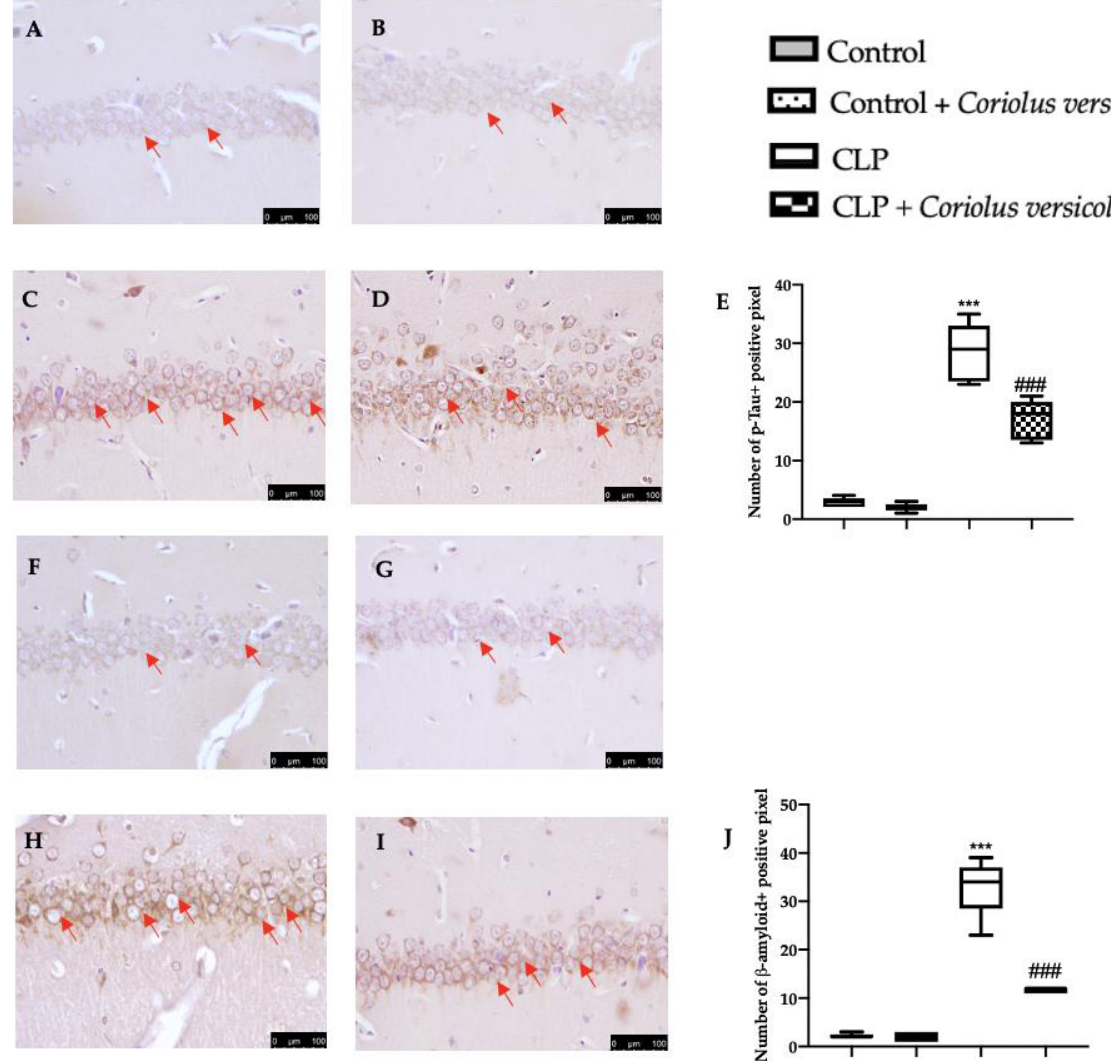
Figure 14. Coriolus versicolor reduced phosphorylated-Tau (p-Tau) and A β expression in hippocampus induced by CLP 28 days after surgery. Immunohistochemical analysis of p-Tau: Control ( A ), Control + Coriolus versicolor ( B ), CLP ( C ), CLP + Coriolus versicolor ( D ), graphical quantification of p-Tau expression ( E ), immunohistochemical analysis of β -amyloid: Control ( F ), Control + Coriolus versicolor ( G ), CLP ( H ), CLP + Coriolus versicolor ( I ), graphical quantification of β -amyloid expression ( J ). ## p < 0.01 vs. CLP, *** p < 0.001 vs. control, ### p < 0.001 vs. CLP.